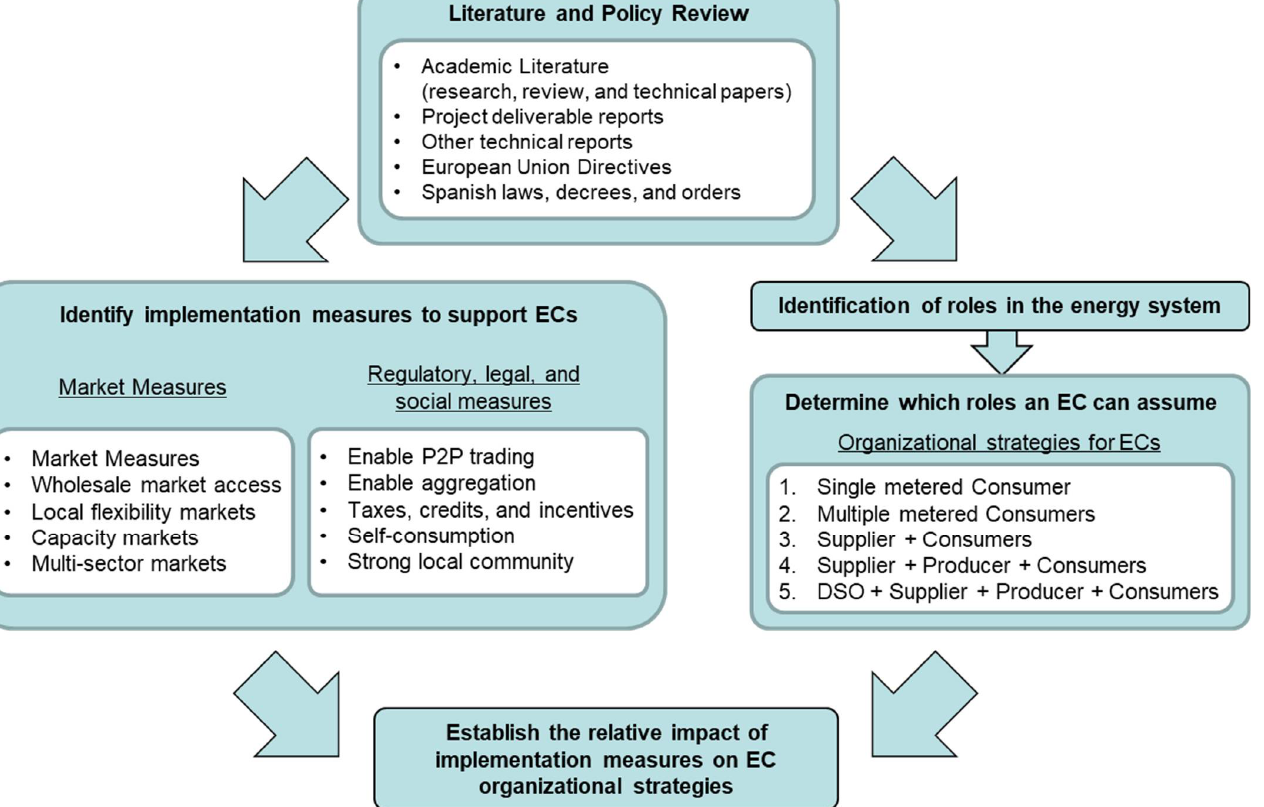
Figure 1. Overview of the selected approach for assessing EC organizational strategies.